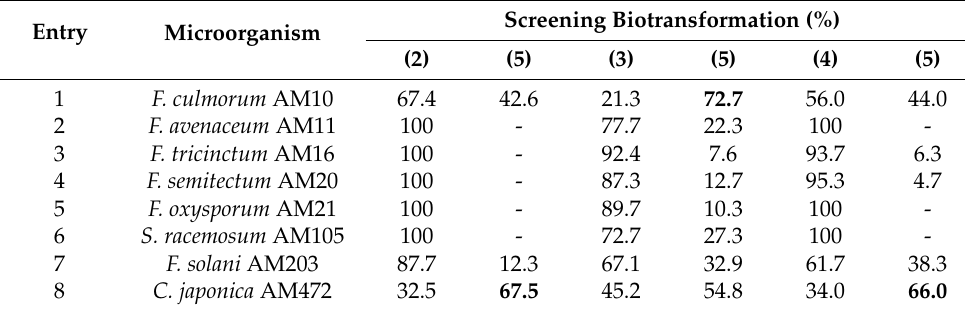
Table 1. The positive results of screening biotransformation of halolactones 2 , 3 and 4 after 7 days of incubation (in % according to GC).